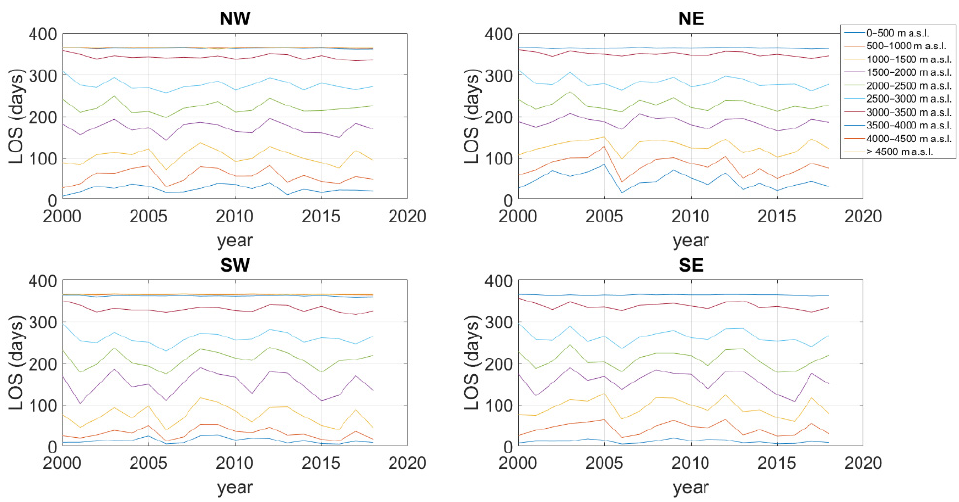
Figure 7. Average Length of Season (LOS) during 2000–2019 in the four subregions of the Greater Alpine Region by elevation band.